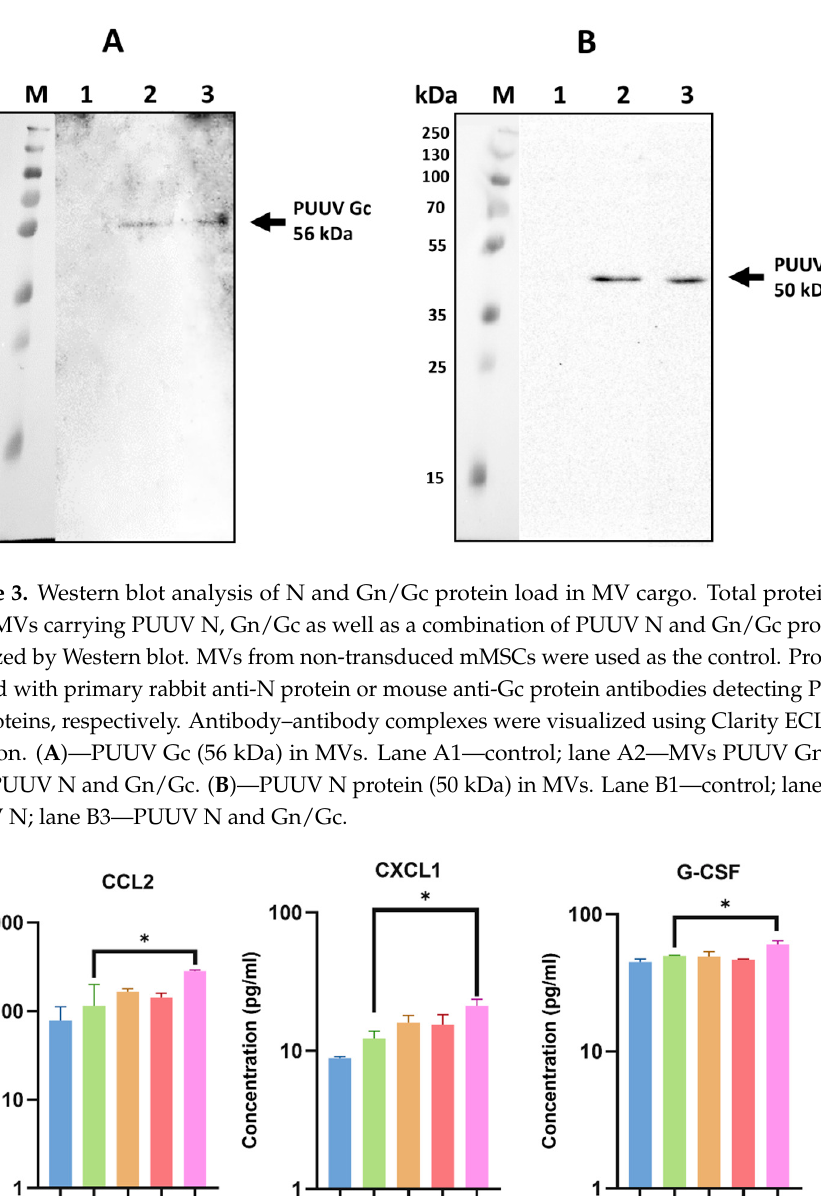
Figure 4. Cytokine and chemokine levels in mMSCs supernatant . mMSCs were transduced with